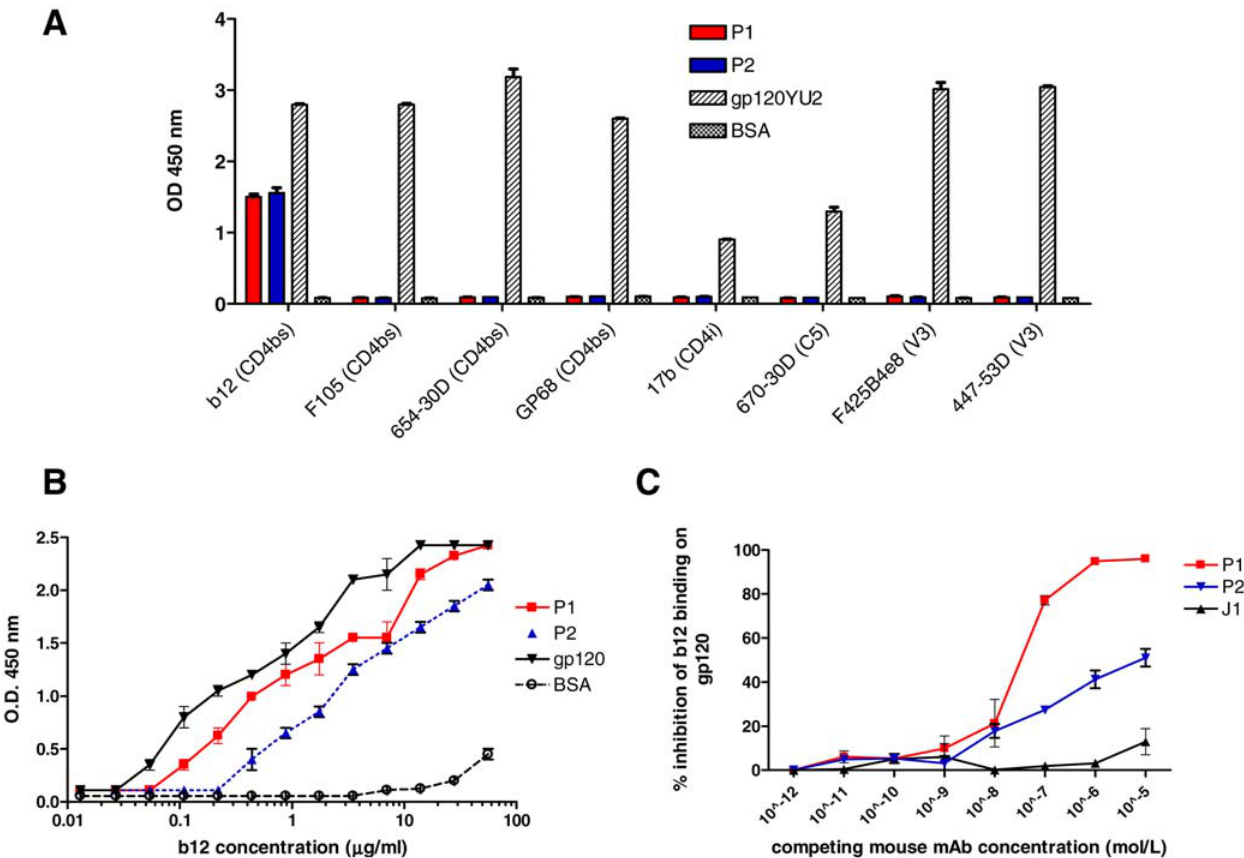
Figure 1. Characterization of P1 and P2 binding features. (a) Recognition of P1 and P2 putative AI molecules by anti-gp120 mAbs. ELISA wells coated with P1, P2, gp120 IIIB (YU2) as positive control, or BSA (negative control) were reacted with: I) four anti-CD4bs mAbs: b12 (1.4 m g/ml), F105 (1.5 m g/ml), 654-30D (1 m g/ml) and GP68 (1 m g/ml); II) two anti-V3 mAbs: F425 B4e8 (1.5 m g/ml) and 447-52D (1 m g/ml); III) one anti-C5 mAb: 670-30D (0.4 m g/ml) and IV) one anti-CD4 induced epitope mAb 17b (1 m g/ml). All monoclonals were obtained through the NIH AIDS Research and